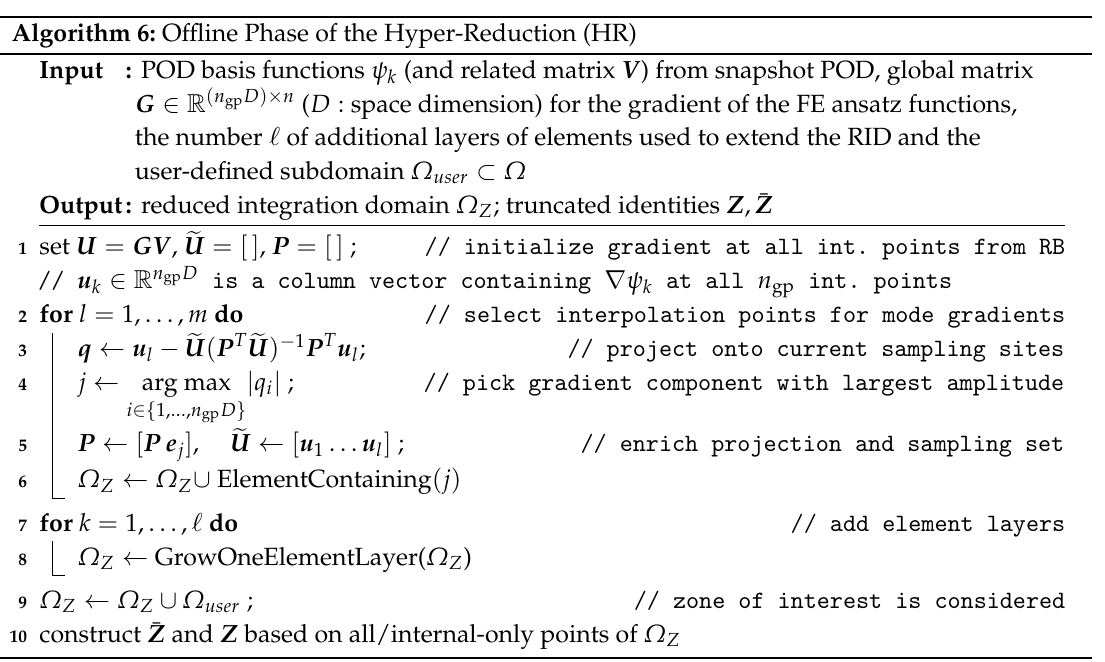
Algorithm 7: Online Phase of the Hyper-Reduction